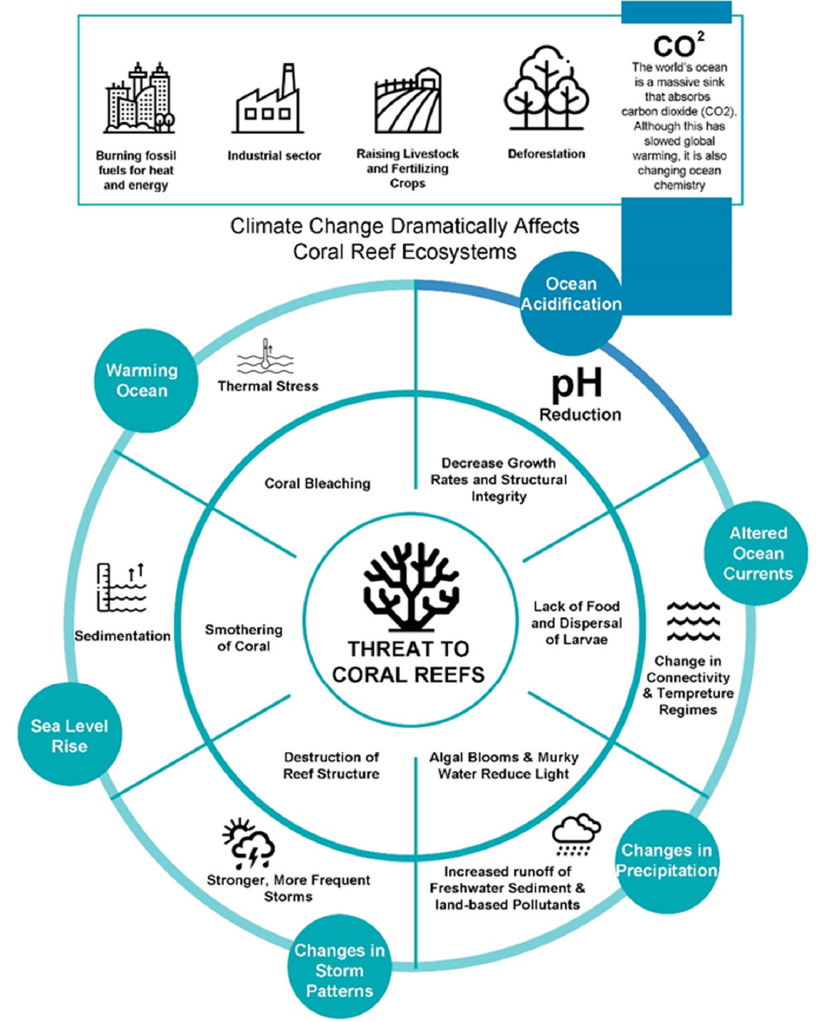
Figure 1. Threats to coral reefs posed by factors related to climate change.